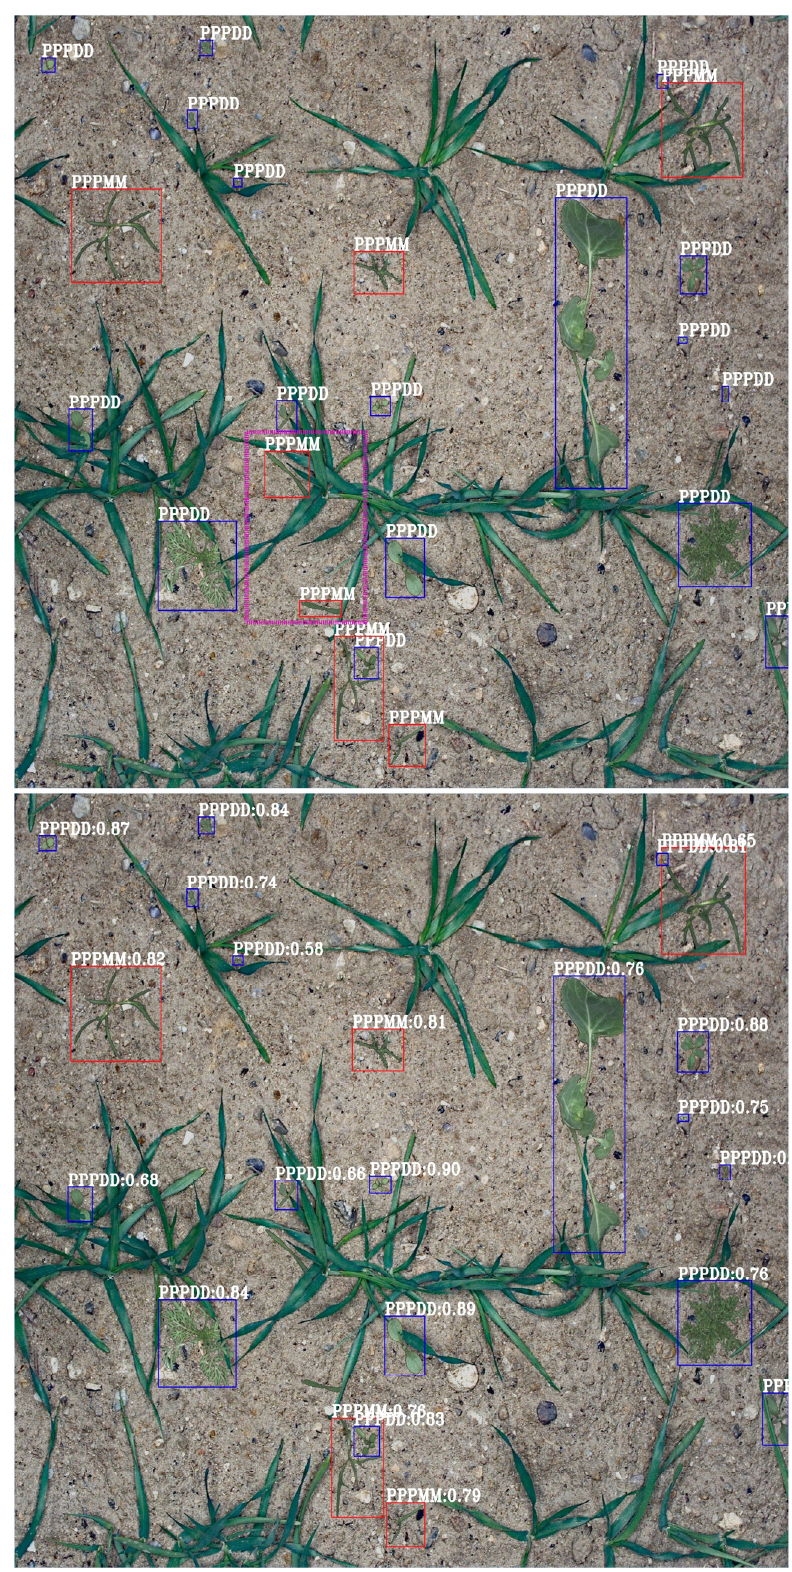
Figure 11. The YOLOv5 results in a random synthetic image. Top : the label, and Bottom : the prediction. The other information is the same as Figure 10.